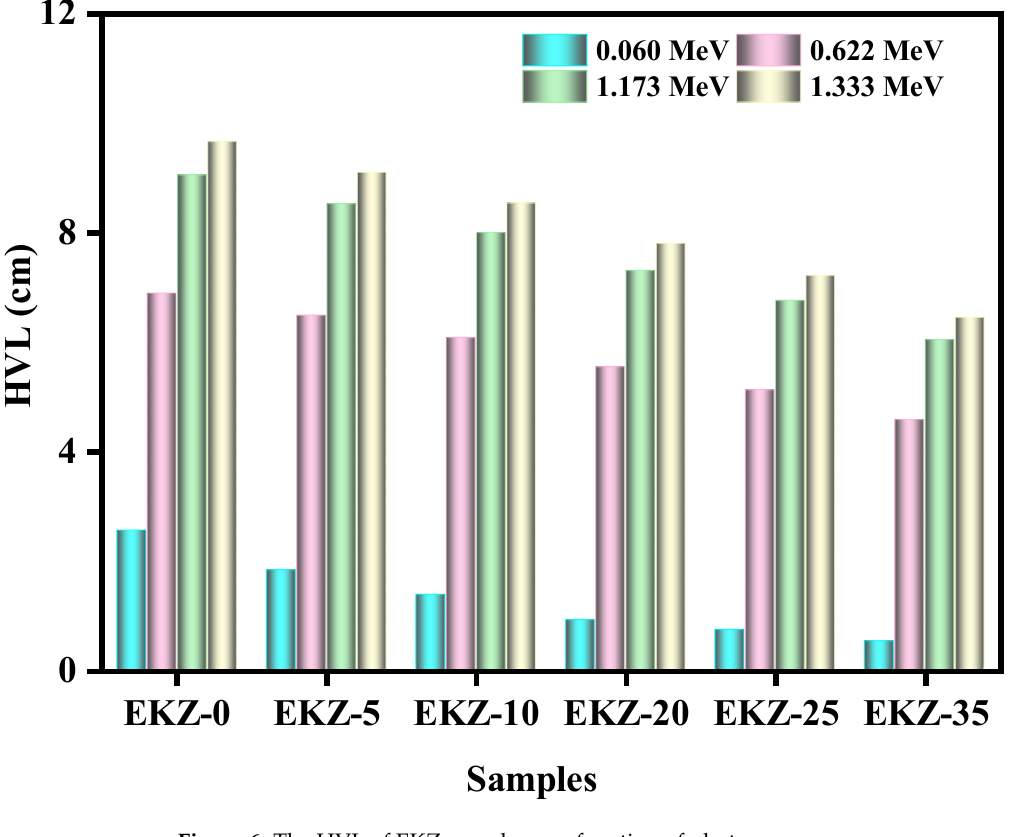
g/cm). It revealed that with the increase of density, the value of HVL has decreased at a specific energy. Figure 6. The HVL of EKZ samples as a function of photon energy. Figure 6. The HVL of EKZ samples as a function of photon energy.